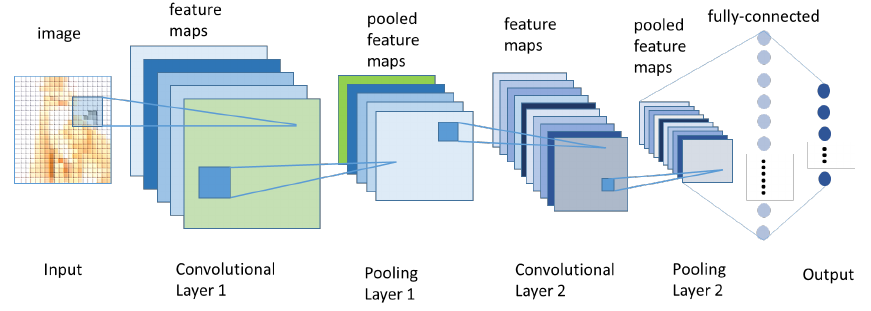
Figure 3. The network architecture of a CNN. Filters (or kernels) are applied in convolutional layers to slide over the image to perform the convolution operation for extracting image features, which are called feature maps. One filter generates one feature map, corresponding to a channel to be fed into the following layer. Note that a non-linear activation function, such as the rectified linear unit (ReLU) function, is applied to the feature map before it is generated. Filters have different sizes and different hyperparameters, such as the stride and the padding. A filter with width w , length l , stride s , and padding p slides over the image in the left-to-right and top-to-bottom manner. When the filter moves, it jumps s pixels for every move, with p of zeros are padded on the image borders. Filters are also used in the pooling layer to slide over image maps for the purpose of subsampling the image maps (i.e., reducing the image map sizes) while maintaining critical image map features. The maximum pooling layer, which returns the maximum value in the filter region, and the average pooling layer, which returns the average of values in the filter region, are two typical pooling layers. Fully connected layers (or dense layers) come after the convolutional and the pooling